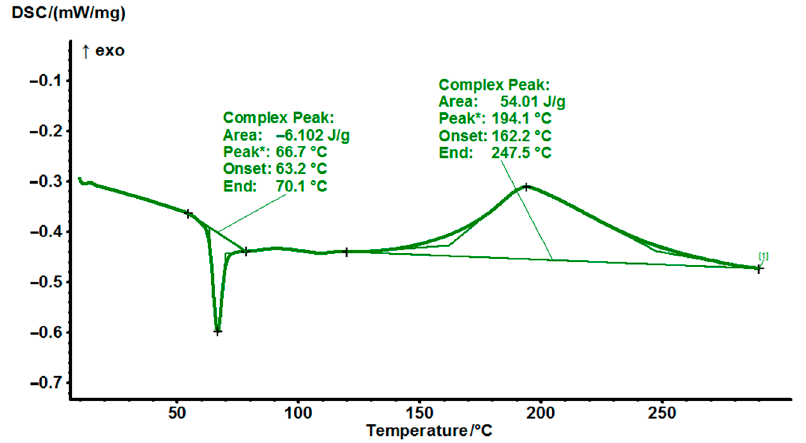
Figure 9. DSC thermograms of non-cured EG531 at a heating rate of 10 °C/min. The SER resin is fully cured using MPD-TPA-MPD as a hardener. For EG531, there are two thermal effects similar to the glass transition temperature on the DSC thermogram, and the glass transition temperature of 90 °C is characteristic for this resin with other hardeners (Figure 10).